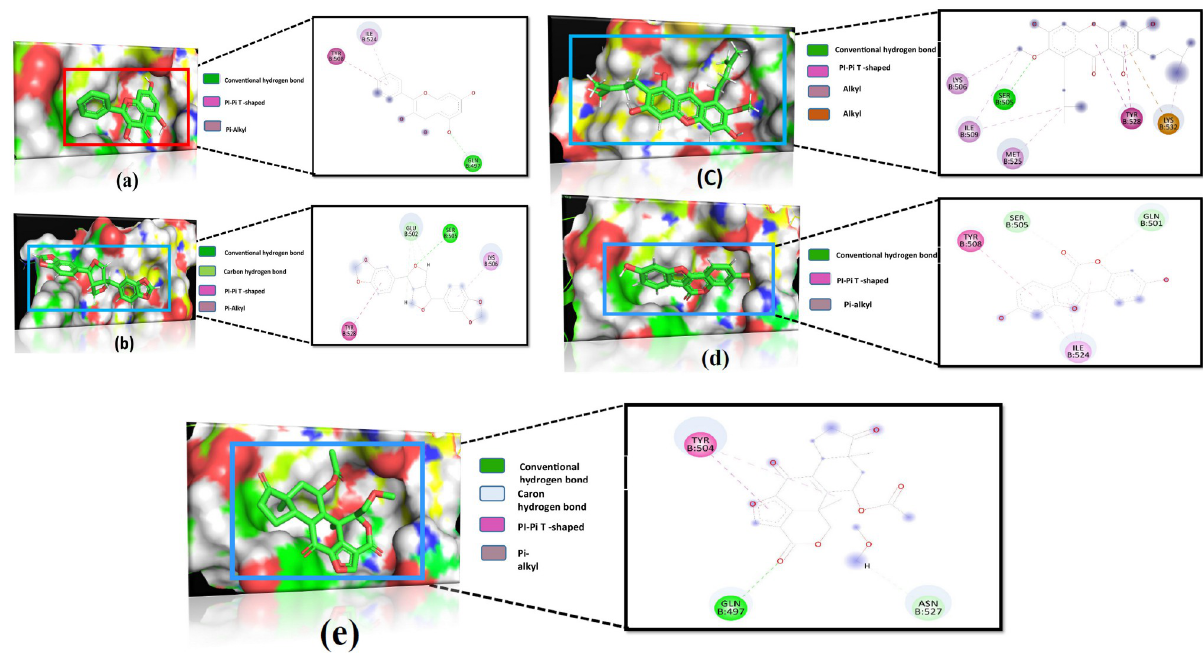
Fig 9. Molecular interactions analysis of selected compounds against PIK3R1 (PDB ID: 5M6U) of (a) galangin, (b) sesamin, (c) alpha-mangostin, (d) coumestrol and (e) control.